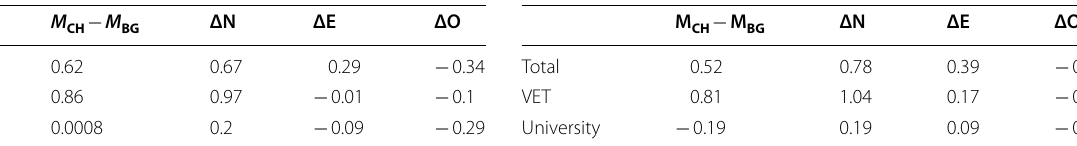
Table 3 Decomposition of the country Table 4